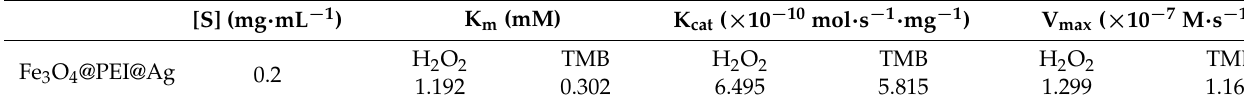
Table 1. Kinetic parameters of the Fe 3 O 4 @PEI@Ag structure.